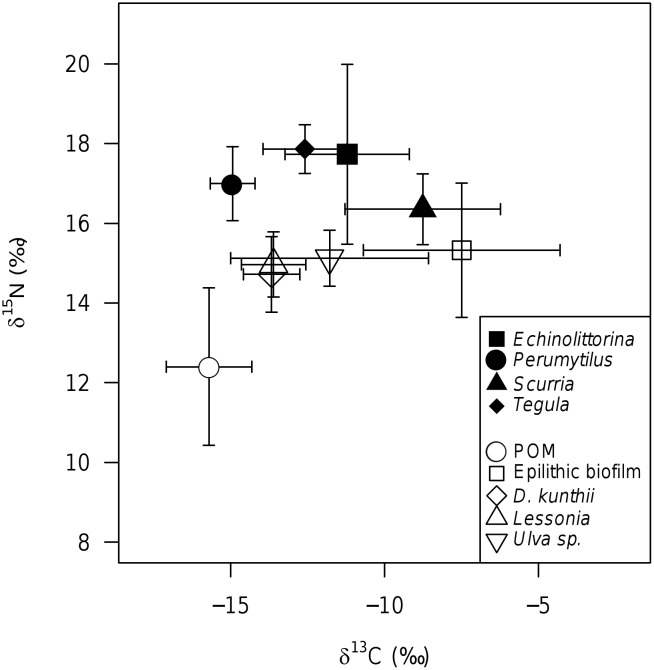
δ13C and δ15N isotopic composition (mean ± SD) of putative resources (open symbols) and consumers (closed symbols) along the coastline of Northern Chile.
D. kunthii was present only at Antofagasta Bay (locations 4 & 5); L nigrescens was absent from Antofagasta Bay (locations 4, 5); S. viridula was absent from Mejillones Bay (location 1).